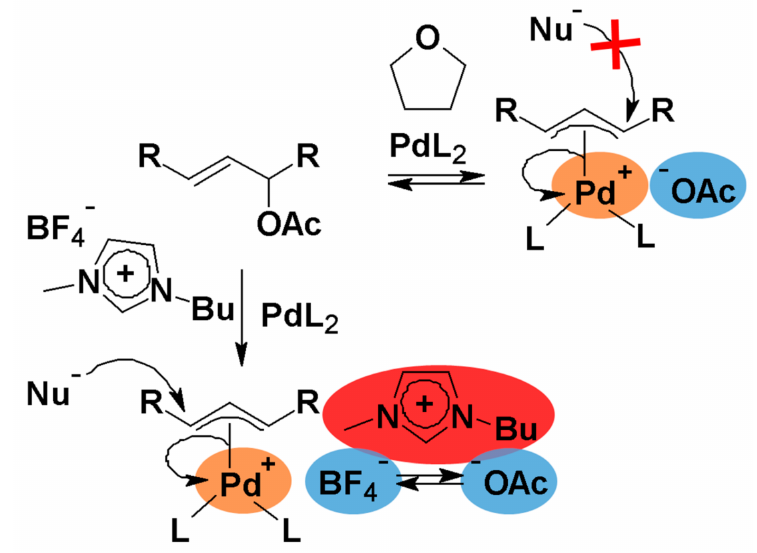
Figure 42. Effects of solvents (THF and 1-butyl-3-methylimidazolium tetrafluoroborate) on the intermediate allylpalladium (PdL 2 = active catalyst, L = phosphine, Nu − = soft